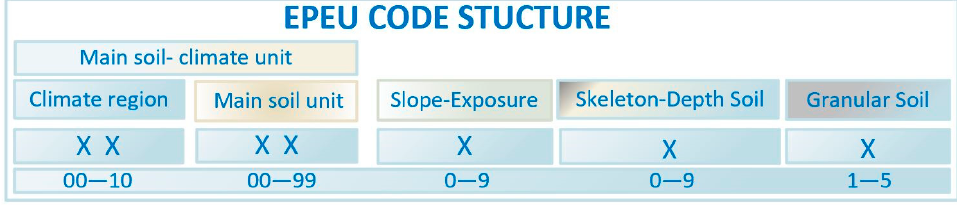
Figure 3. EPEU code structure.